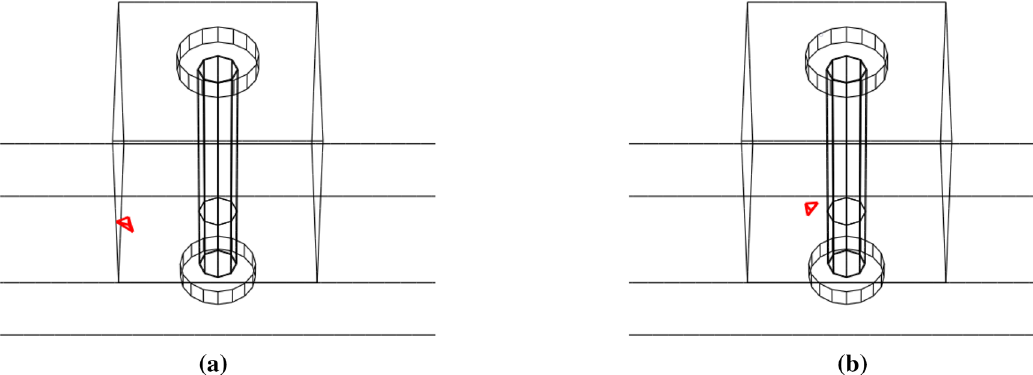
Fig. 9 Location of a element 13,366 and b element 8792